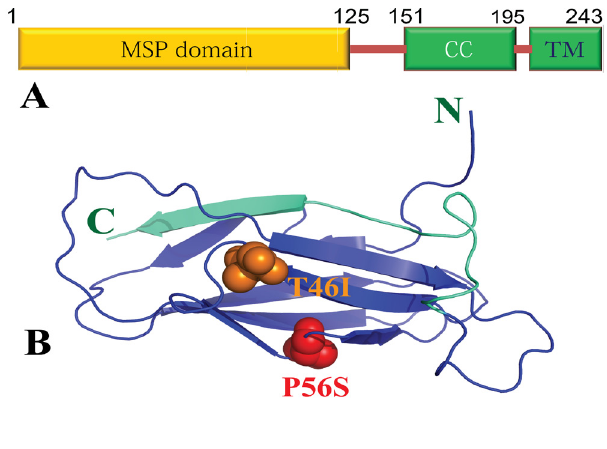
Figure 3. Domain organization and crystal structure of VAPB. ( A ) 243-residue human VAPB protein is composed of the 125-residue major sperm protein (MSP), coiled coil (CC) and transmembrane (TM) domains. ( B ) Crystal structure of the 125-residue MSP domain of the human VAPB protein. Two residues, Pro56 and Thr46 are displayed in spheres, whose mutations to Ser and Ile respectively lead to familiar amyotrophic lateral sclerosis. The N-terminal 105 residues (in blue) are identical in both the MSP domain and VAPB-3, a splicing variant of VAPB, while the last 20 residues (in green) of the MSP domain are absent in